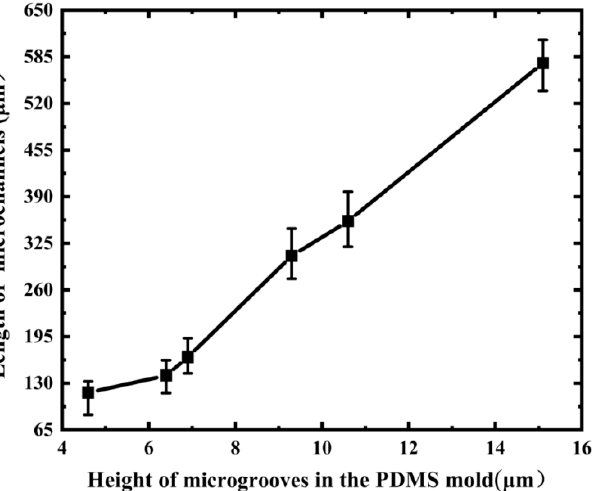
Figure 4. Length of microchannels versus the height of 40 μ m wide microgrooves in the PDMS mold.